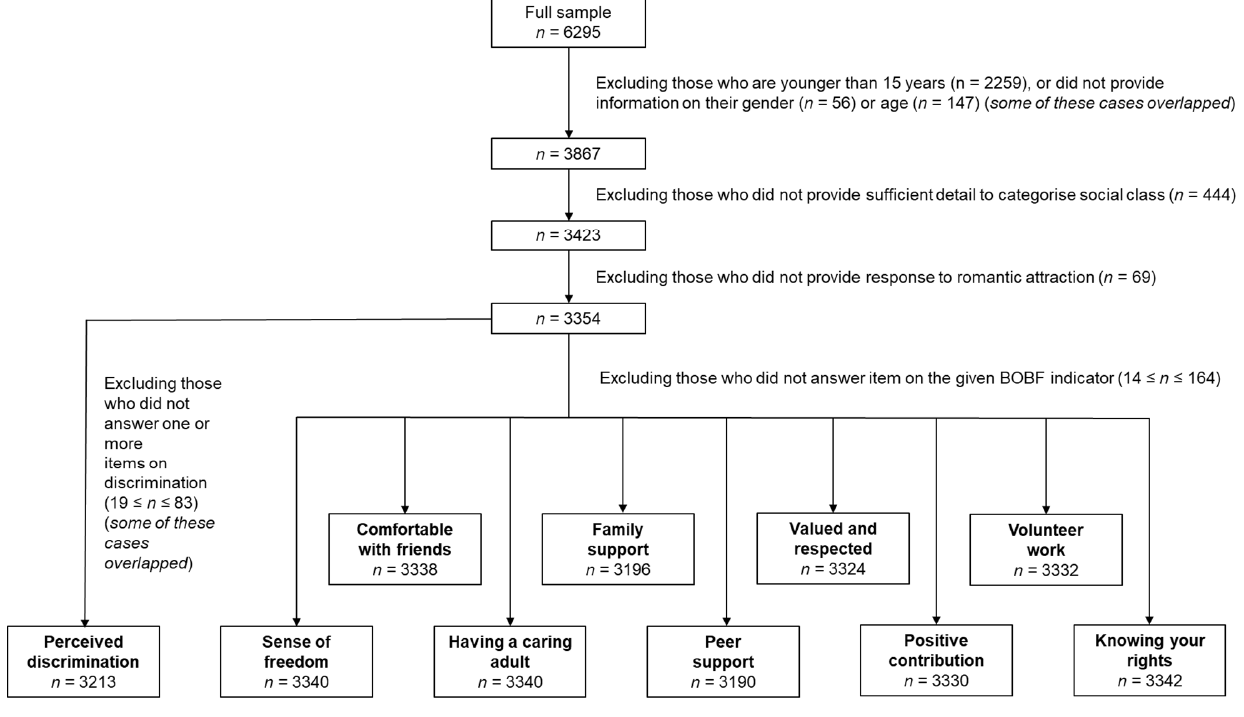
Figure 1. Selection flowchart.